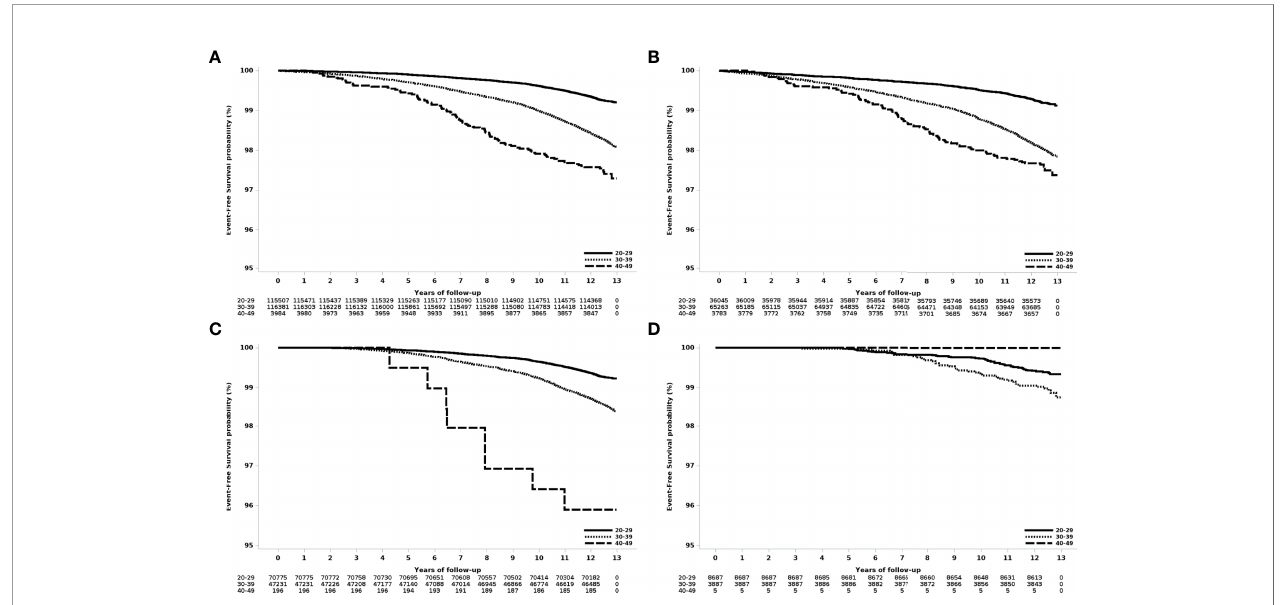
FIGURE 1 | Event-free survival according to age at fi rst delivery in women who gave birth in 2007. (A) All patients, (B) those with one delivery, (C) those with two deliveries, and (D) those with three or more